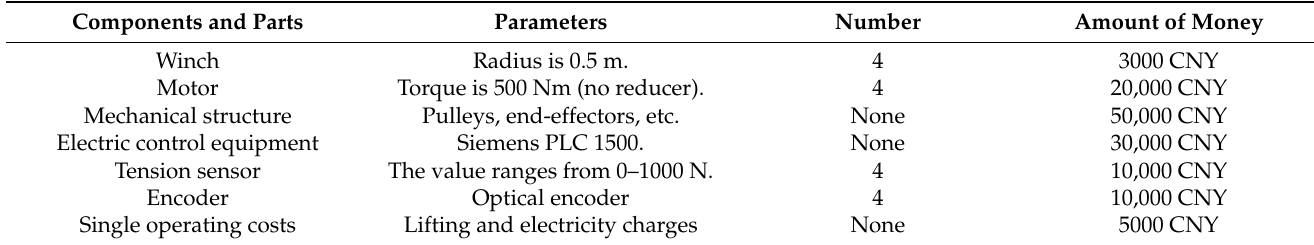
Table 1. Operation cost of